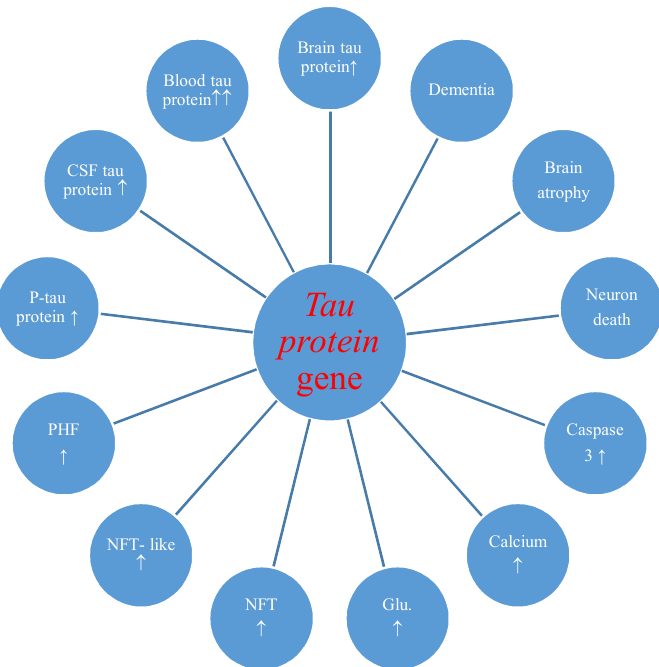
Figure 2. Potential role of tau protein gene changes during brain injury due to ischemia-reperfusion. CSF-cerebrospinal fluid, P-tau-phosphorylated tau protein, PHF-paired helical filaments, NFT-like- neurofibrillary tangle-like, NFT-neurofibrillary tangle, Glu.-glutamate, ↑